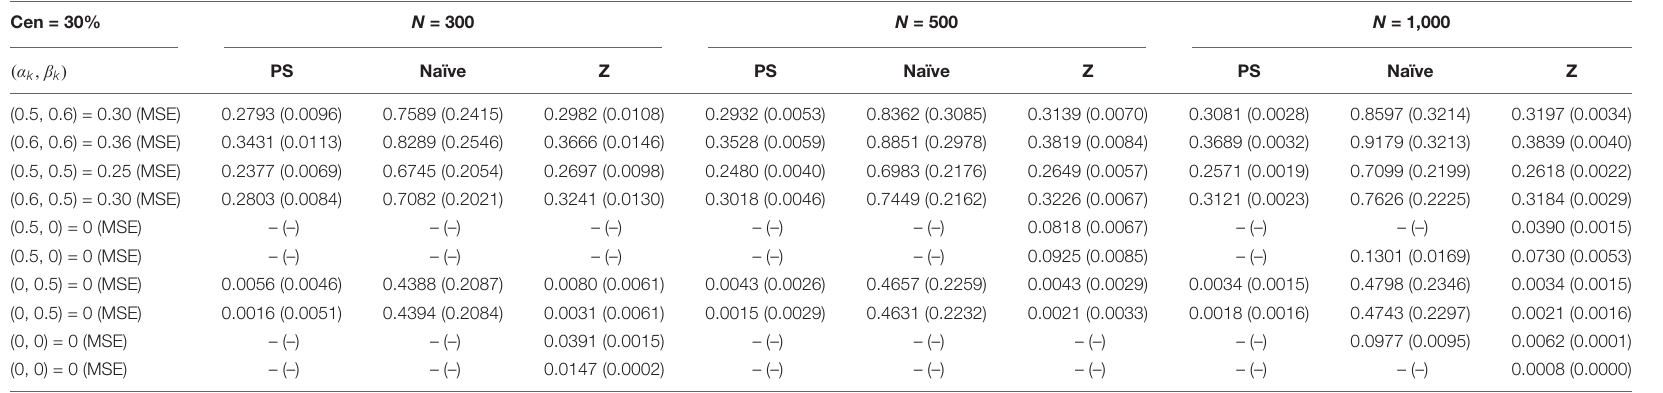
TABLE 3 | Estimation of log hazard mediation effects: α k β k (Cen =